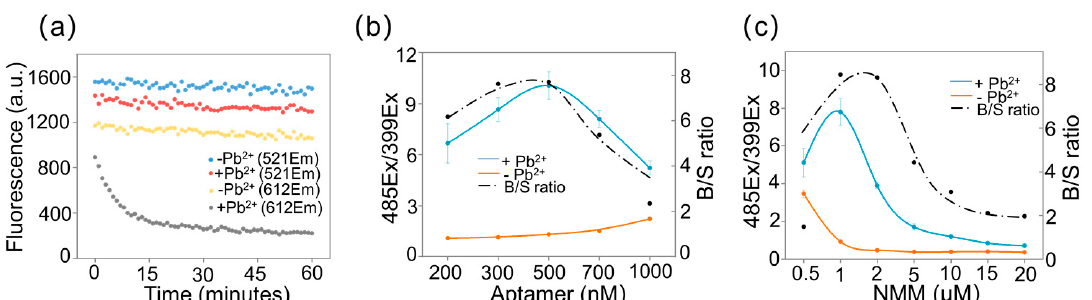
Figure 3. ( a ) Real-time fluorescence of FAM (excited at 485 nm and collected at 521 nm) in the presence (the red dotted line) and absence (the blue dotted line) of Pb 2+ and real-time fluorescence of NMM (excited at 399 nm and collected at 612 nm) in the presence (the grey dotted line) and absence (the yellow dotted line) of Pb 2+ . ( b ) Optimization of aptamer concentrations (200, 300, 500, 700, 1000 nM). ( c ) Optimization of NMM concentrations (0.5, 1, 2, 5, 10, 15 and 20 μ M).